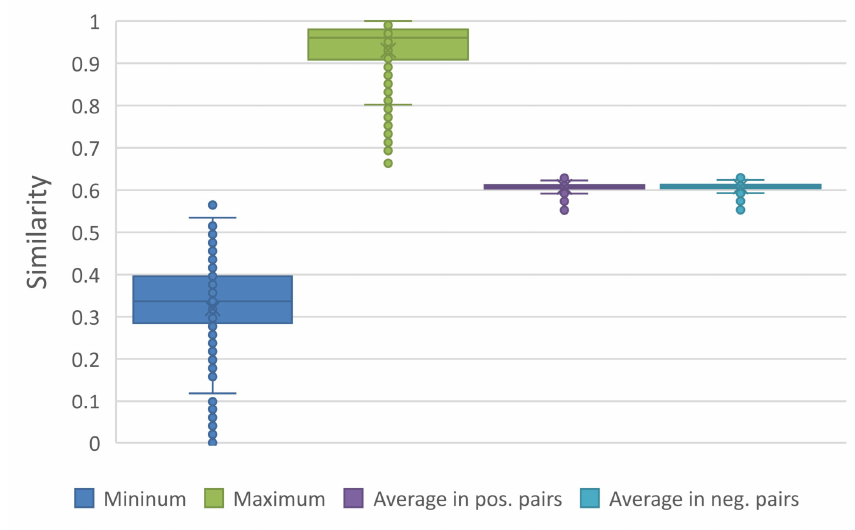
Figure 3. Maximum, minimum and average similarities in all datasets. Abbreviation pos. (positive) means the pairs with a same supervised label, and neg. (negative) means those with different label (similarly